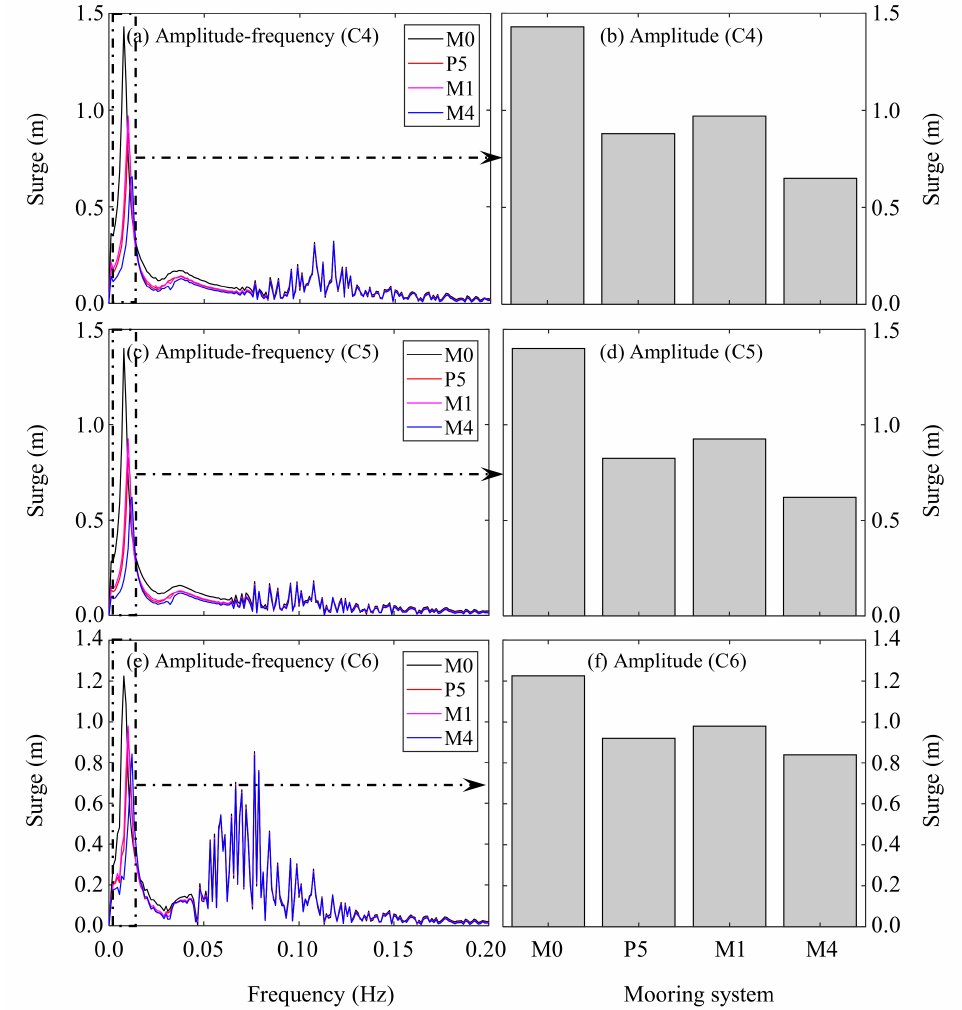
Figure 22. Wind turbine surge movement in frequency domain with M0, P5, M1, and M4 when under: ( a ) amplitude-frequency (C4); ( b ) amplitude (C4); ( c ) amplitude-frequency (C5); ( d ) amplitude (C5); ( e ) amplitude-frequency (C6); ( f ) amplitude